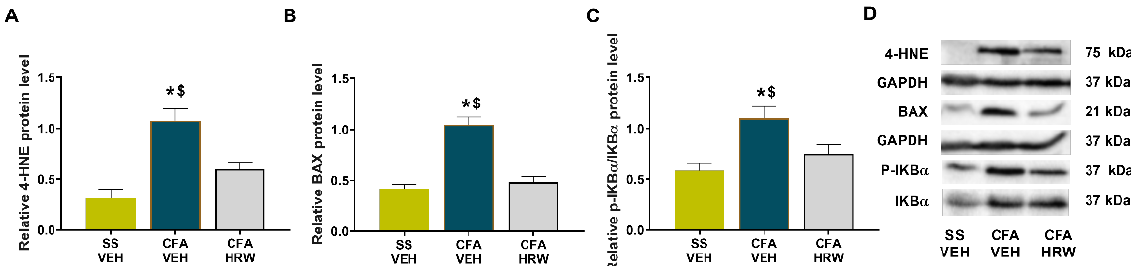
Figure 8. Effects of treatment with HRW on the expression of 4-HNE, BAX, and p-IKB α in the amygdala of CFA-injected mice. The protein levels of 4-HNE ( A ), BAX ( B ), and p-IKB α ( C ) in the amygdala of CFA-injected mice treated with VEH or HRW are shown. SS-injected mice treated with VEH, used as controls, are also shown. Examples of blots for 4-HNE, BAX, and p-IKB α are displayed ( D ). 4-HNE and BAX are expressed relative to GAPDH levels, while p-IKB α is expressed relative to IKB α . In all graphics, * denotes significant differences vs. SS-injected mice plus VEH, and $ denotes significant differences vs. CFA-injected animals plus HRW ( p < 0.05; one-way ANOVA and Student– Newman–Keuls test). Data are shown as the mean ± SEM; n = 3 samples.